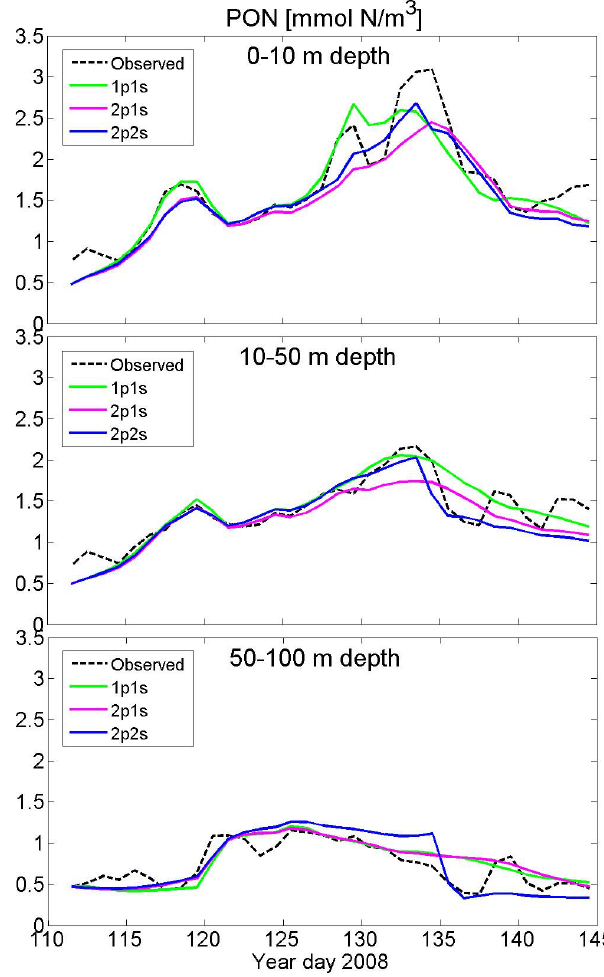
Fig. 5. Observed and simulated mean PON concentrations for dif- ferent depth